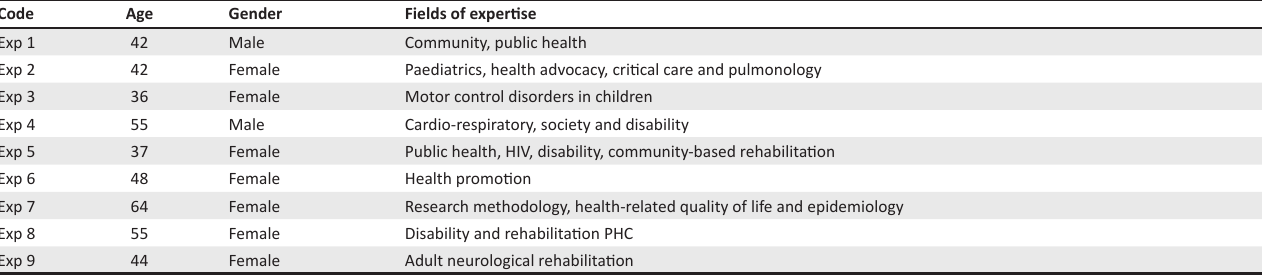
TABLE 1: Demographic characteristics of the participants.